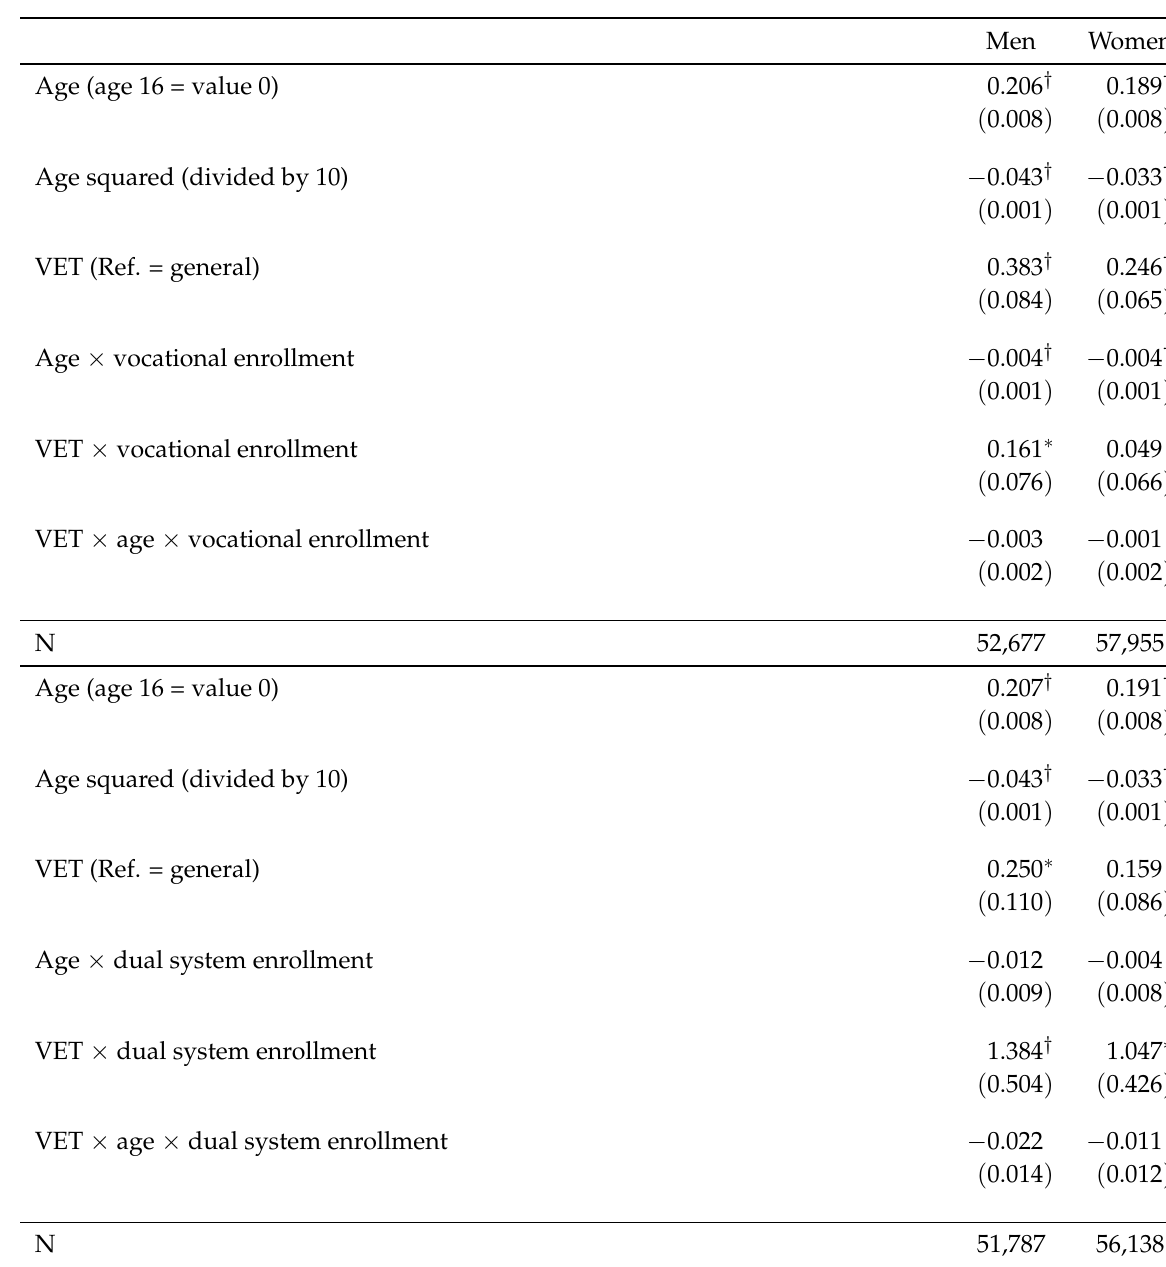
Table 3: Three-Way Interaction Logistic Regression Models with Country-Level Indicators and Employment as Dependent Variable (Selected